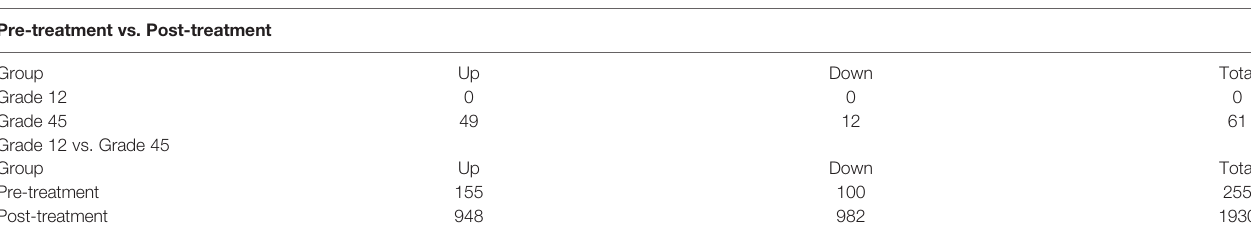
TABLE 1 | Statistics of the number of differentially expressed genes. Pre-treatment vs. Post-treatment